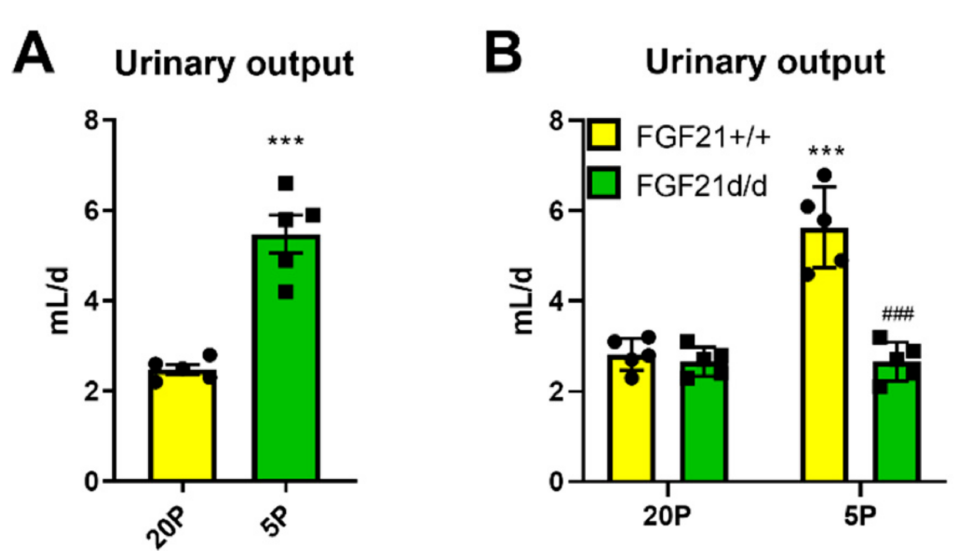
Figure 5. Liver-derived FGF21 is necessary for the heightened urinary response to dietary protein restriction. ( A ): Water intake rate of mice in response to treatment with diets containing 20% energy from protein (20P) or 5% energy from protein (5P). Data are mean ± SEM; n = 5 per group. Different than 20P. ( B ): Urinary volume output rate of wildtype (Fgf21+/+) and germline knockout (Fgf21d/d) littermate mice in response to treatment with diets containing 20% calories from protein (20P) or 5% calories from protein (5P). Data are mean ± SEM ( n = 5 per group). Different than 20P: *** p < 0.001. Different than Fgf21+/+: ### p < 0.001. Statistical analyses: Student’s t -test ( A ), two-way measures ANOVA ( B